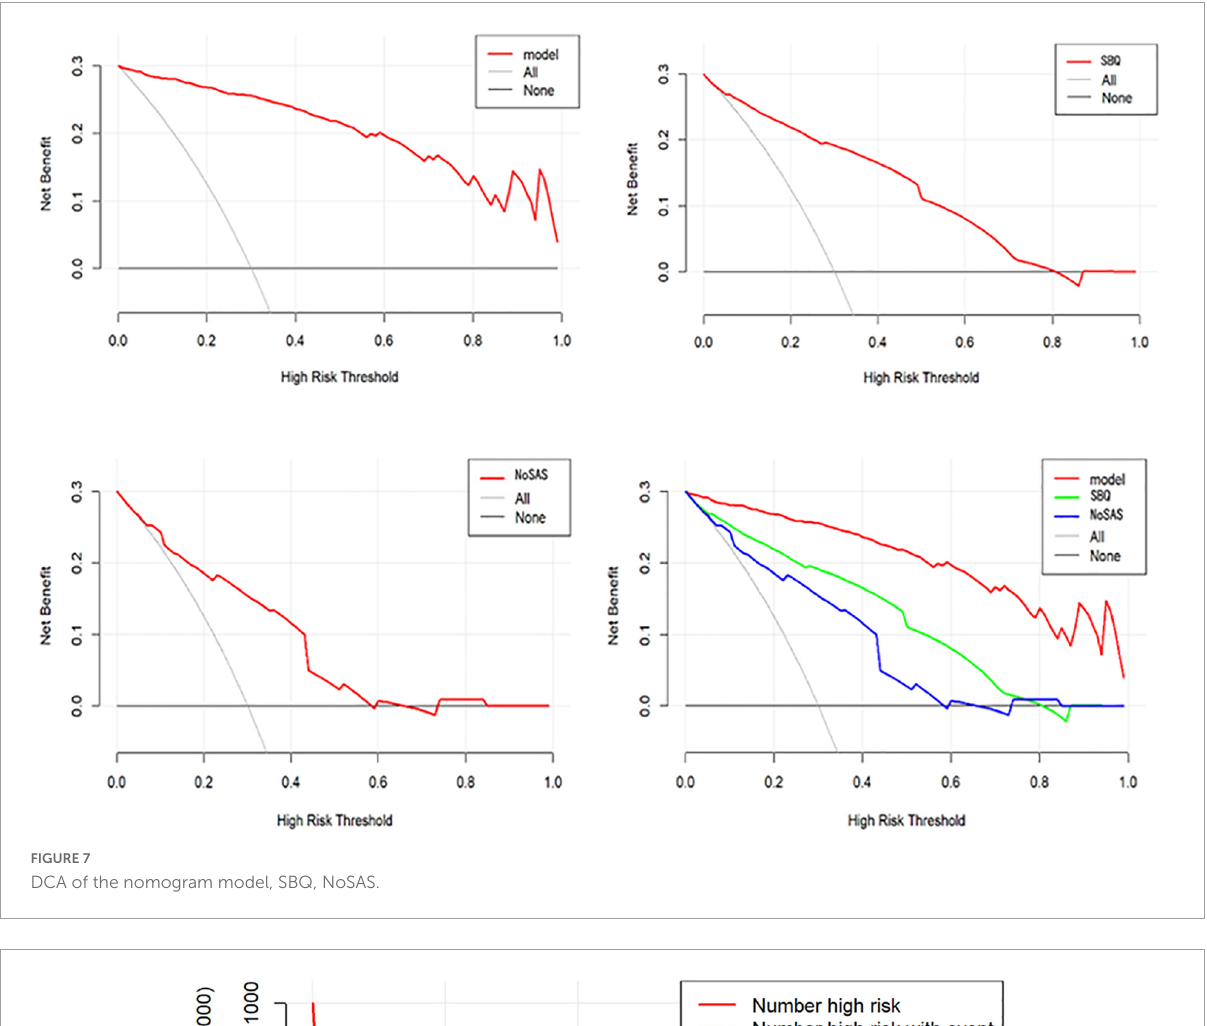
FIGURE7 DCA of the nomogram model, SBQ, NoSAS.